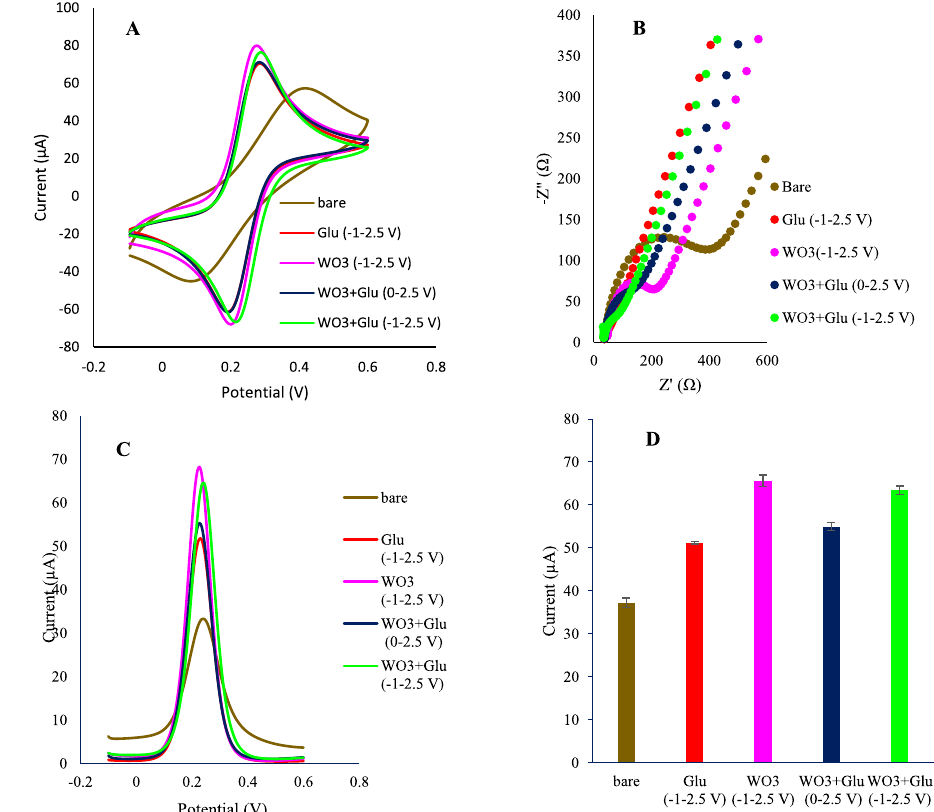
Figure 3. The effect of the potential range and composition of the electrodeposition solutions. ( A ) the CVs voltammograms; ( B ) EIS plots; ( C ) DPV voltammograms and ( D ) DPV correlated histograms. The electrochemical measurements were obtained in a PBS buffer (pH = 7.4) of 5 mM K 4 [Fe(CN) 6 ] and 0.1 M KCl. All the DPV measurements were obtained in tha potential range of − 0.1 to 0.6 V with pulse amplitude of 5 mV with interval time of 0.5